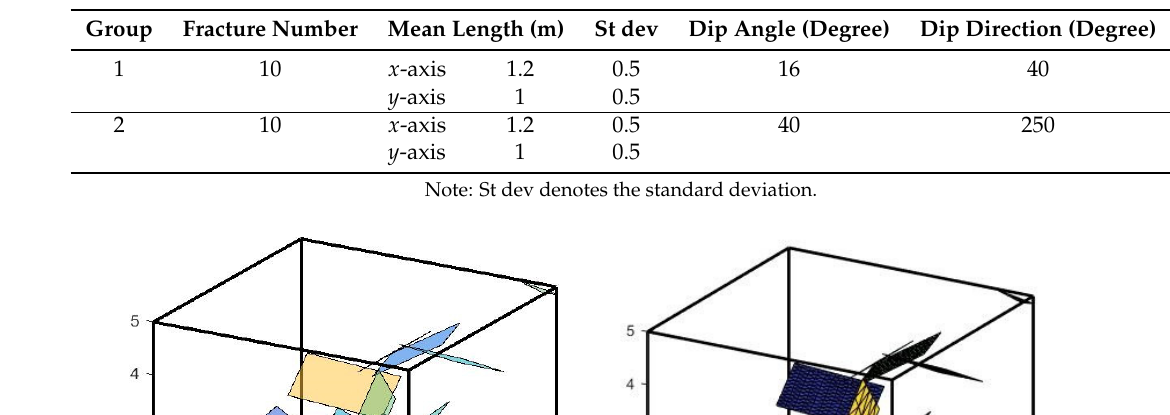
Table 3. Parameters adopted for the generation of the fracture models.